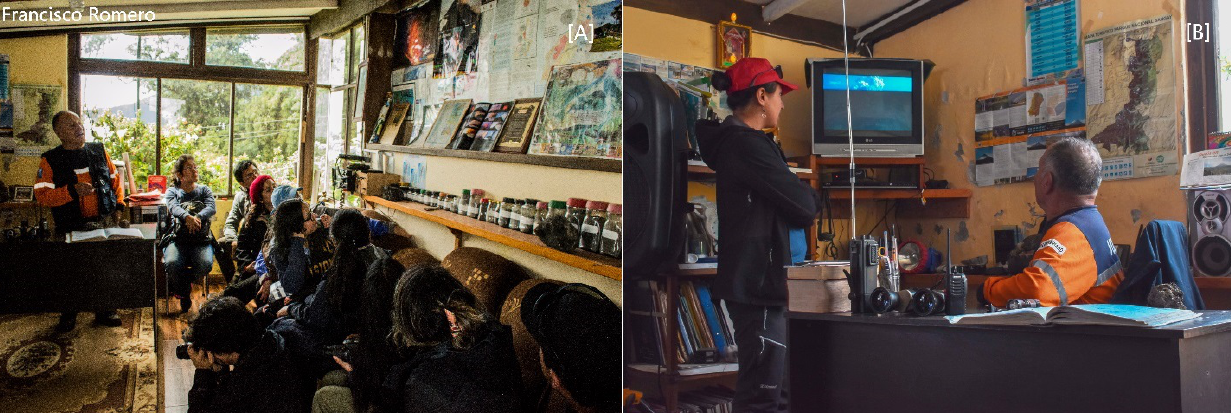
identified communication problems (see Section 2)